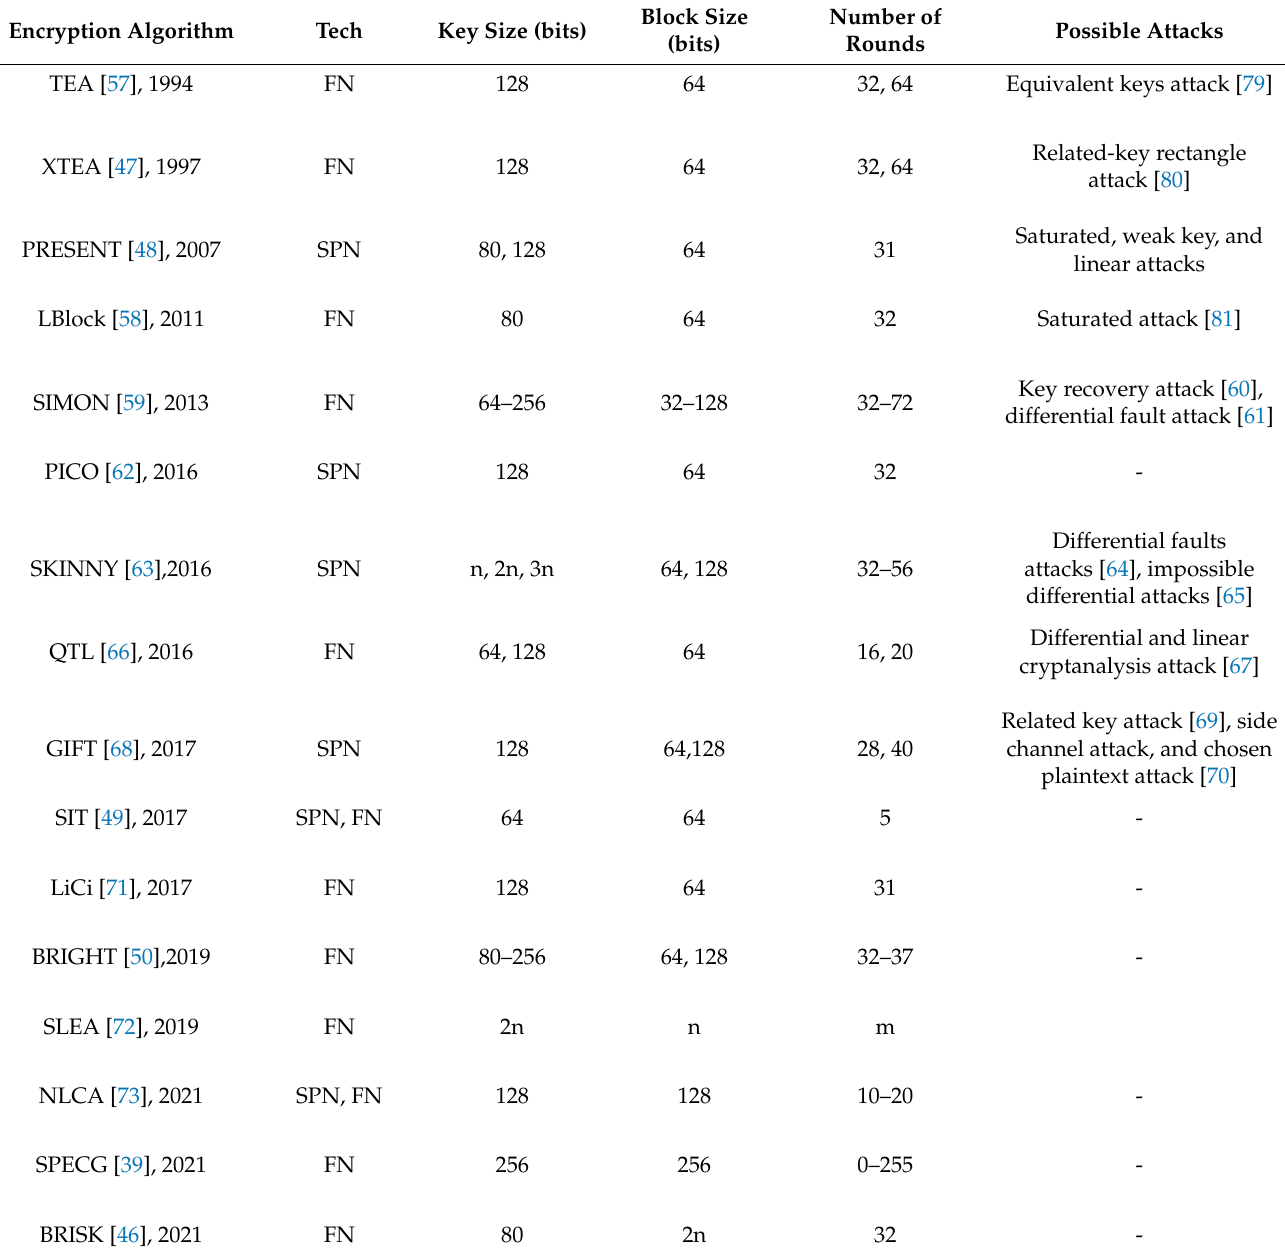
Table 1. Summary of some of the existing light-weight symmetric block cipher algorithms based on substitution–permutation network (SPN) and Feistel network